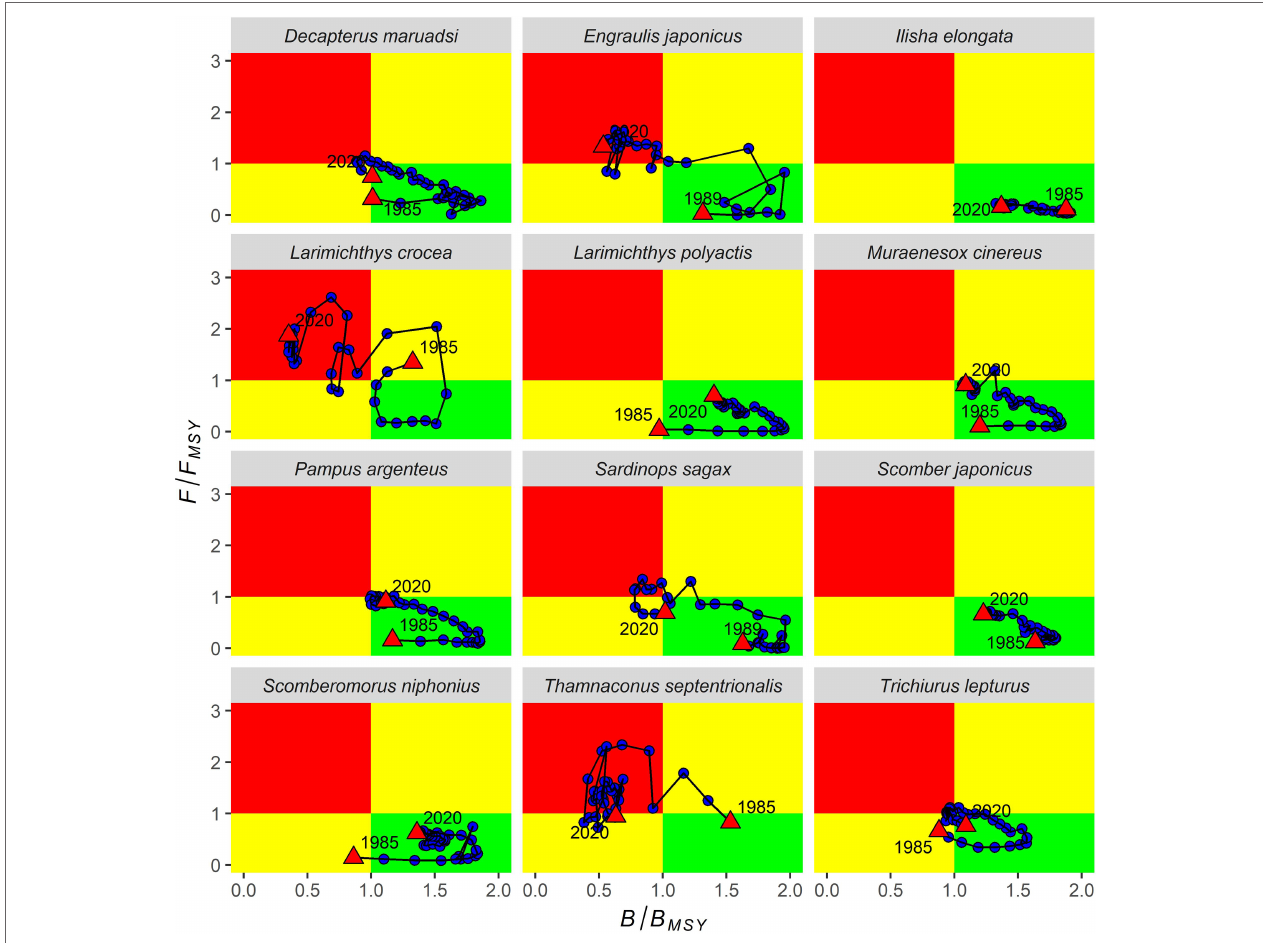
FIGURE 7 | Kobe plot showing the stock status of the stocks of ECS from 1985 to 2020, calculating by the weighted quantities ( B , B MSY , F , and F MSY ). The green quadrant indicates healthy stock status, the yellow quadrants indicate the stock is either overfished (B/B MSY <1) or subject to overfishing (F/F MSY >1). The red quadrant indicates the stock is both overfished and subject to